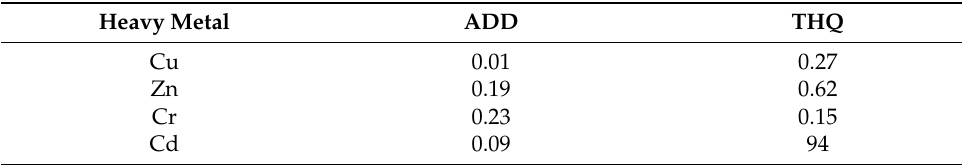
Table 4. Average Daily Dose (ADD) and Target Hazard Quotient (THQ) at SOCHE